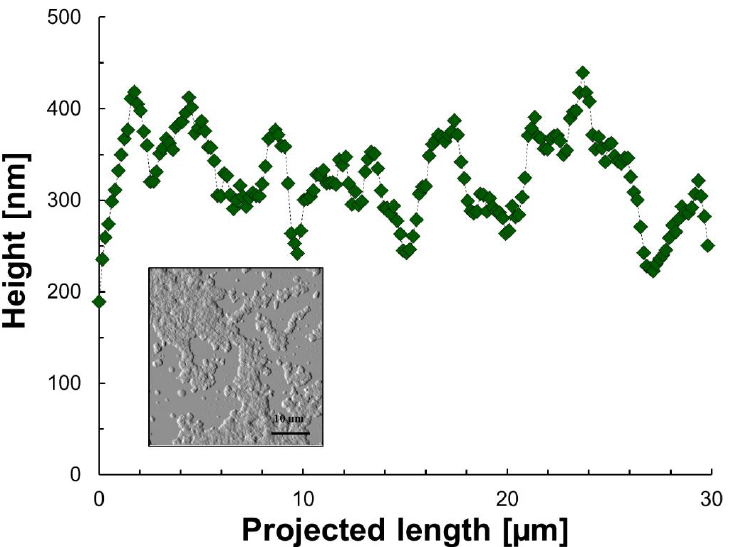
Figure 3. Height as a function of the projected length and morphology of aggregates/sediment of model 1 after n- heptane and toluene evaporation. The green icons are the experimental points, the dashed line is for illustrative purposes only and the image is to show the area where data was extracted.